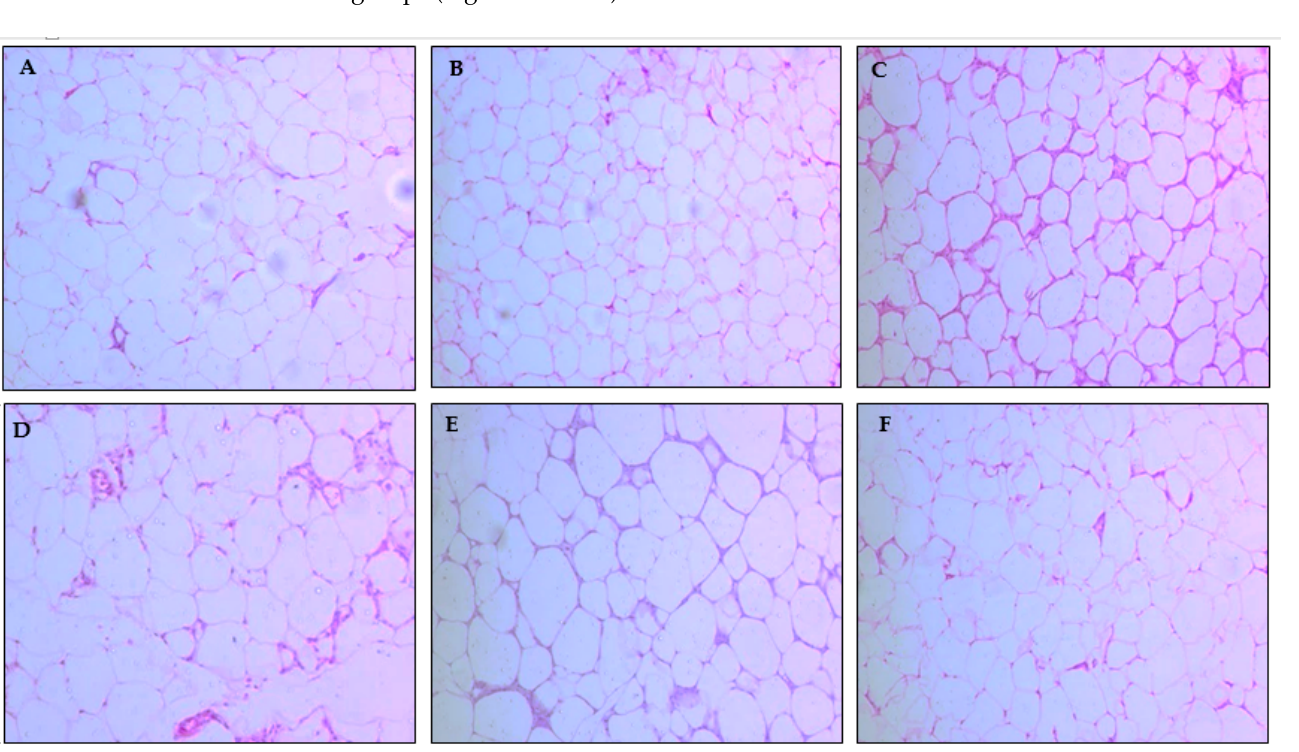
Figure 2. Histopathological analysis of the adipose tissue via hematoxylin and eosin (H&E—200X) for animals fed a balanced or high-fat diet and supplemented with saline, soybean oil, olive oil, or seed oil of papaya ( Carica papaya Linn). Bar scale: 100 μ m. ( A ) CT; ( B ) AIN-93; ( C ) HPL; ( D ) HPL OS; ( E ) HPL AZ; and ( F ) HPL OM.